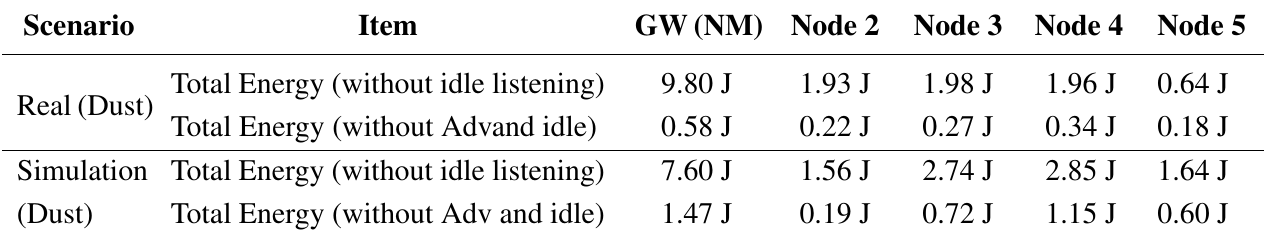
Table 6. Energy-consumption in the network (in 25,000 s) during normal operation. GW: gateway; NM: network